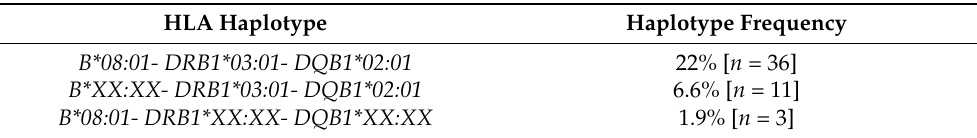
Table 2. Frequencies and linkage disequilibrium of three-locus HLA-B-DRB1-DQB1 haplotypes in Graves’ disease (GD) patients depending on the presence of the HLA-B*08:01